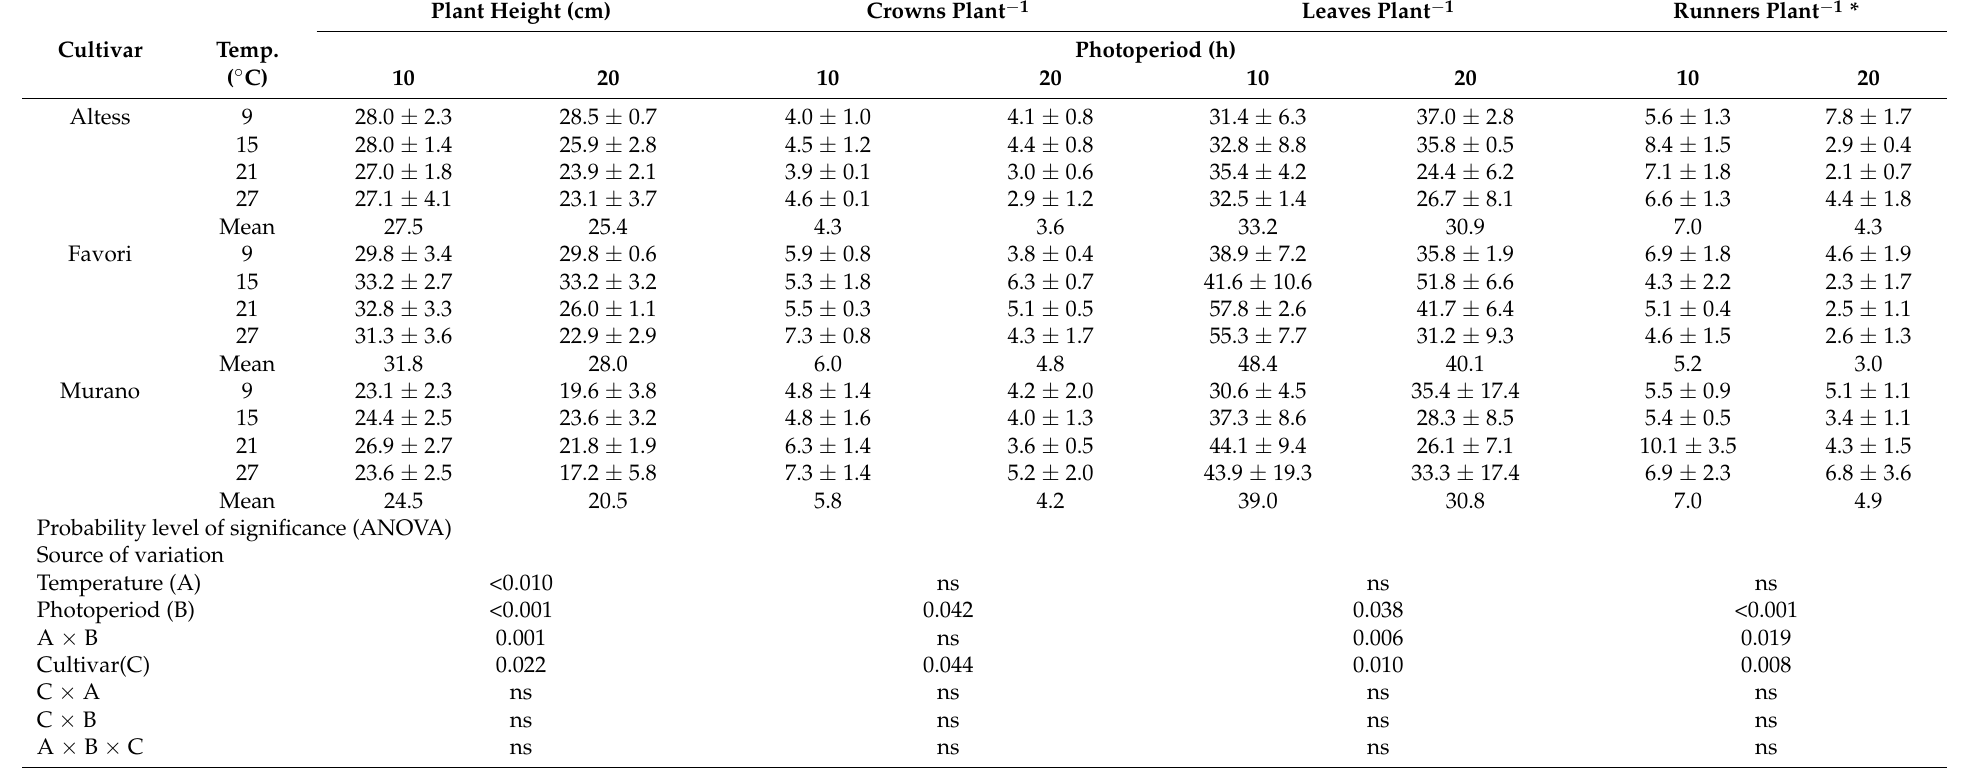
Table 2. Effects of raising temperature and photoperiod on plant architecture in three EB strawberry cultivars grown on a tabletop system in a plastic high tunnel in the year after treatment. Data are means ± SD of three replicates, each with four plants of each cultivar. Plant Height (cm) Crowns Plant − 1 Leaves Plant − 1 Runners Plant − 1 * Cultivar